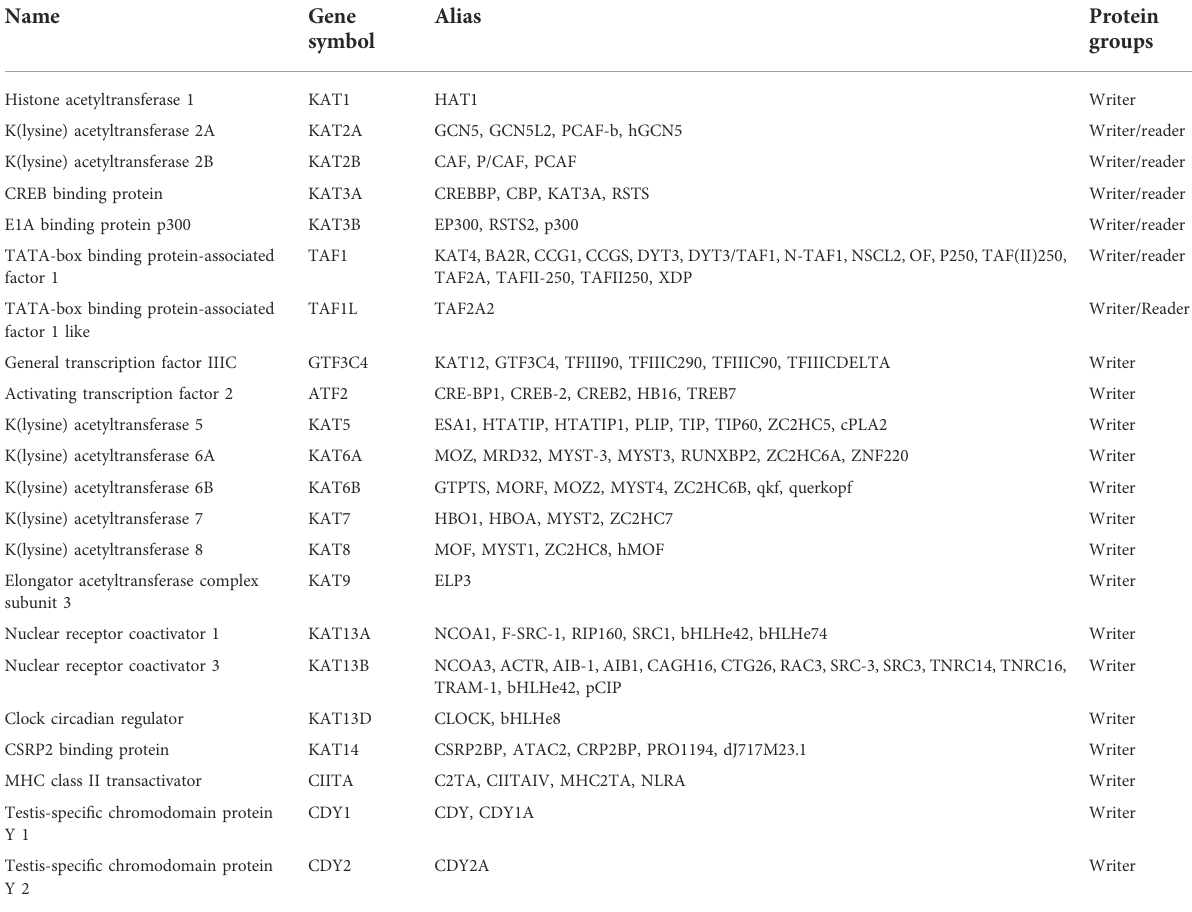
TABLE 2 Classi fi cation, formal names, and aliases of